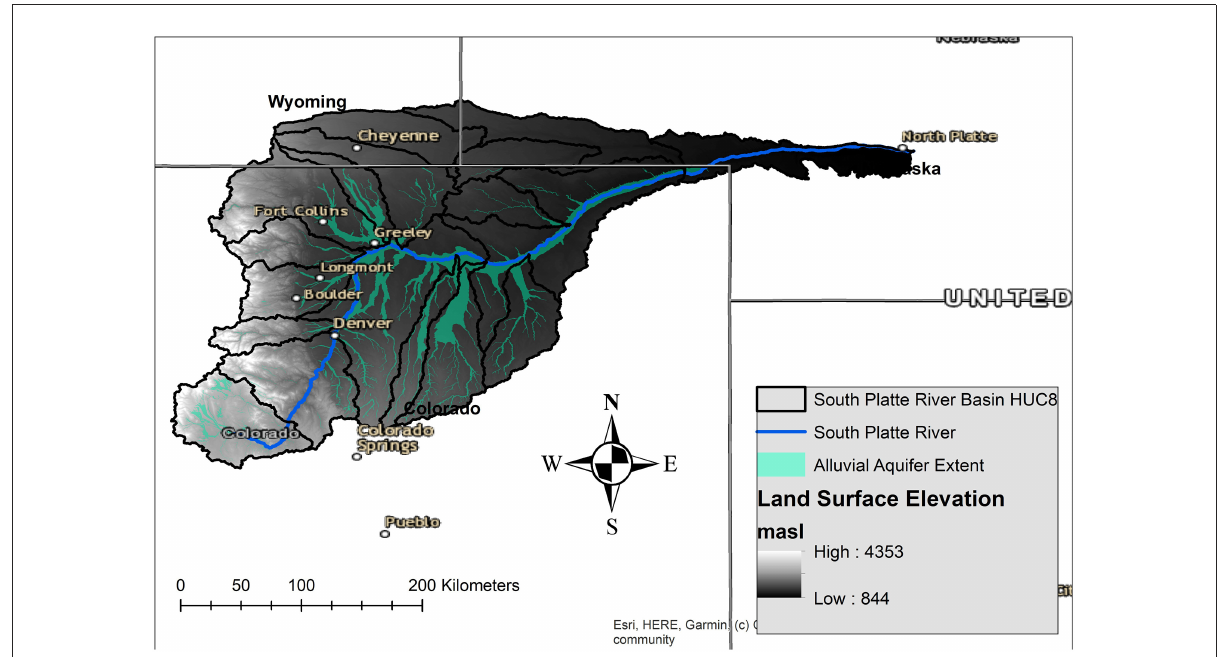
FIGURE1 Spatial extent of the South Platte River Basin (SPRB), showing land surface elevation (m above sea level), boundaries of HUC8 subbasins, and extent of the alluvial